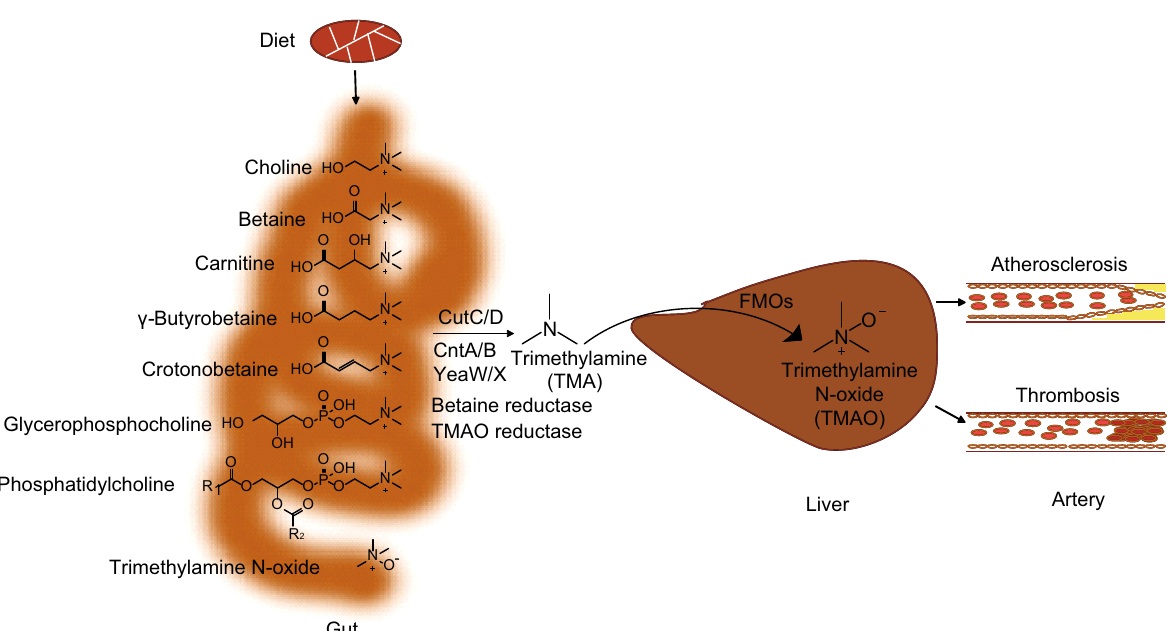
Figure 1. Metaorganismal pathway of trimethylamine N oxide (TMAO) biosynthesis and linking to cardiovascular disease. FMOs, Flavin monooxygenases. R1, R2, CH 3 (CH 2 )n 1 (CH=CH)n 2 , n 2 = 0, 1, 2 … ..6, n 1 +2n 2 = 15, 17, 19,